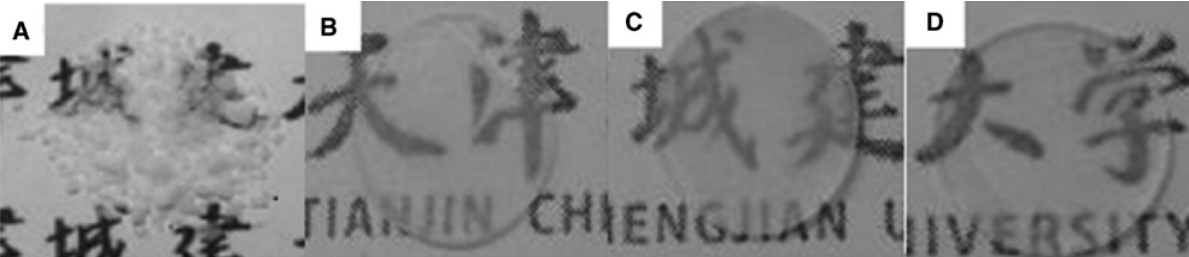
Figure 1: Photographs of (A) silica aerogel (SA), (B) SA-poly(methyl methacrylate) (PMMA), (C) SA-KH570/PMMA, (D) SA-amino-capped polydivinylsiloxane (AP)/PMMA.